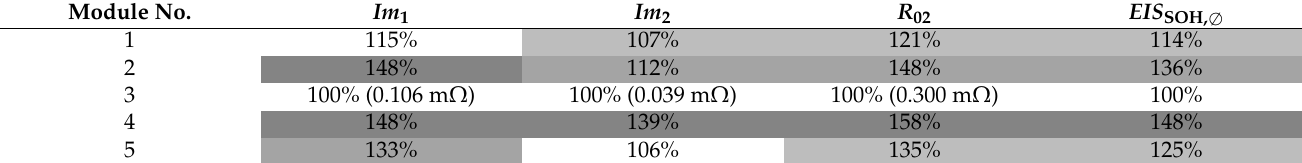
Table 5. Evaluation of the module spectra with the characteristic points. Shading represents the order of the aged modules. Module No.